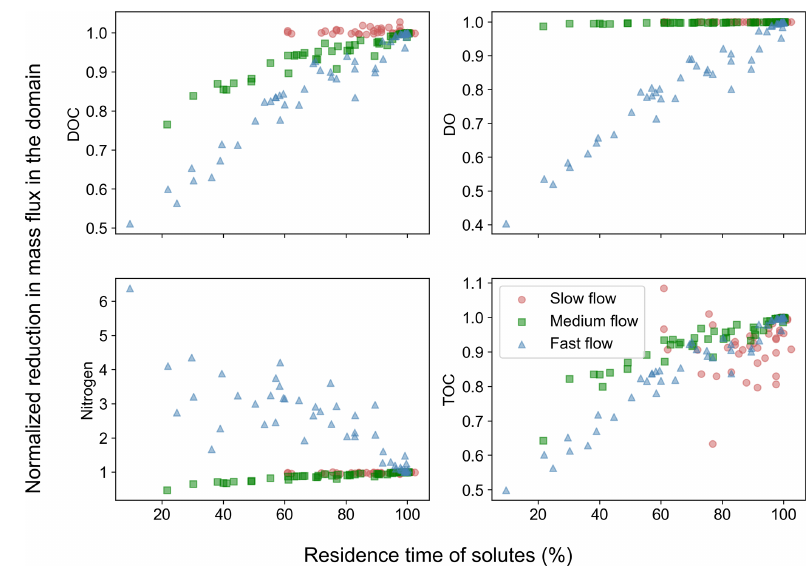
Figure 4. Removal of chemical species in spatially heterogeneous domains in different flow regimes. Values show mass flux differences between inlet and outlet of the heterogeneous domains normalized by the flux differences for the homogeneous base case of each flow regime.